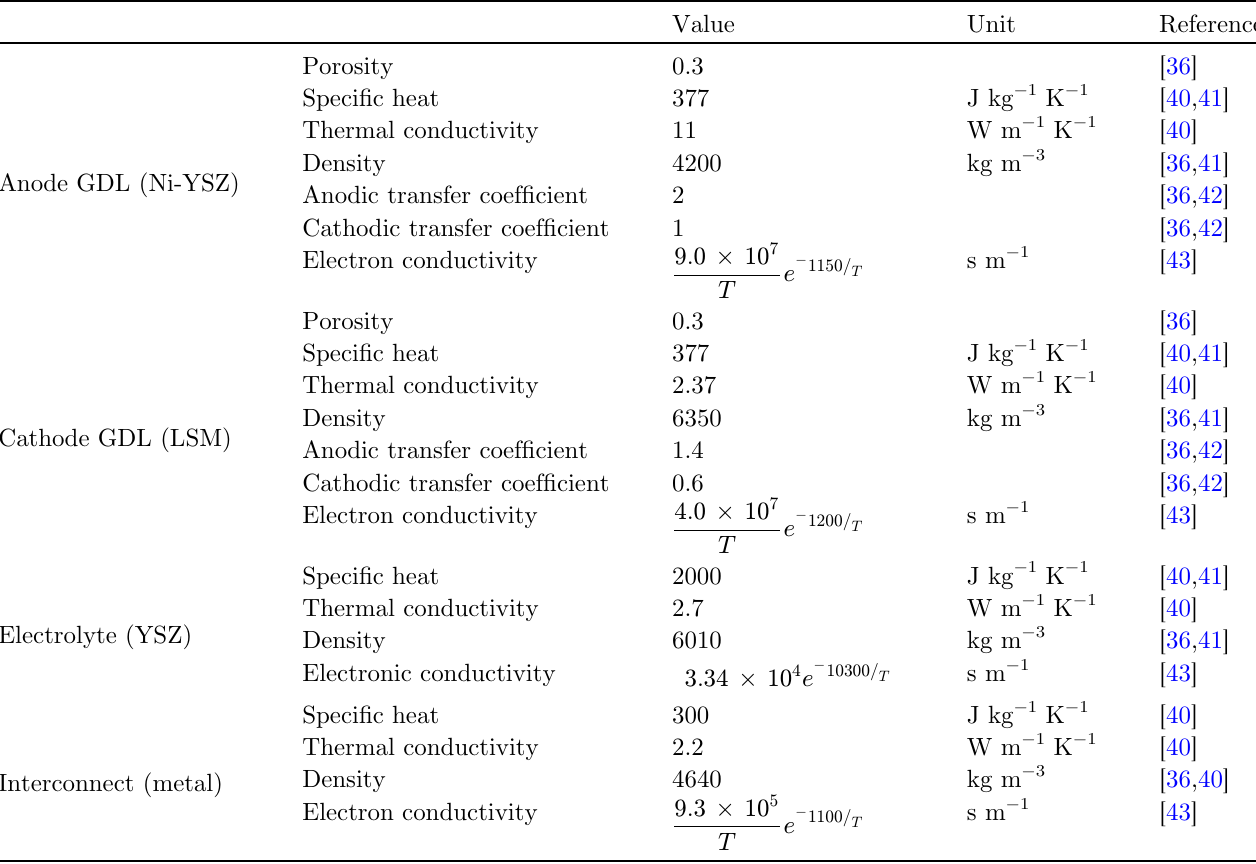
Table 3. Speci fi cations of the case study.